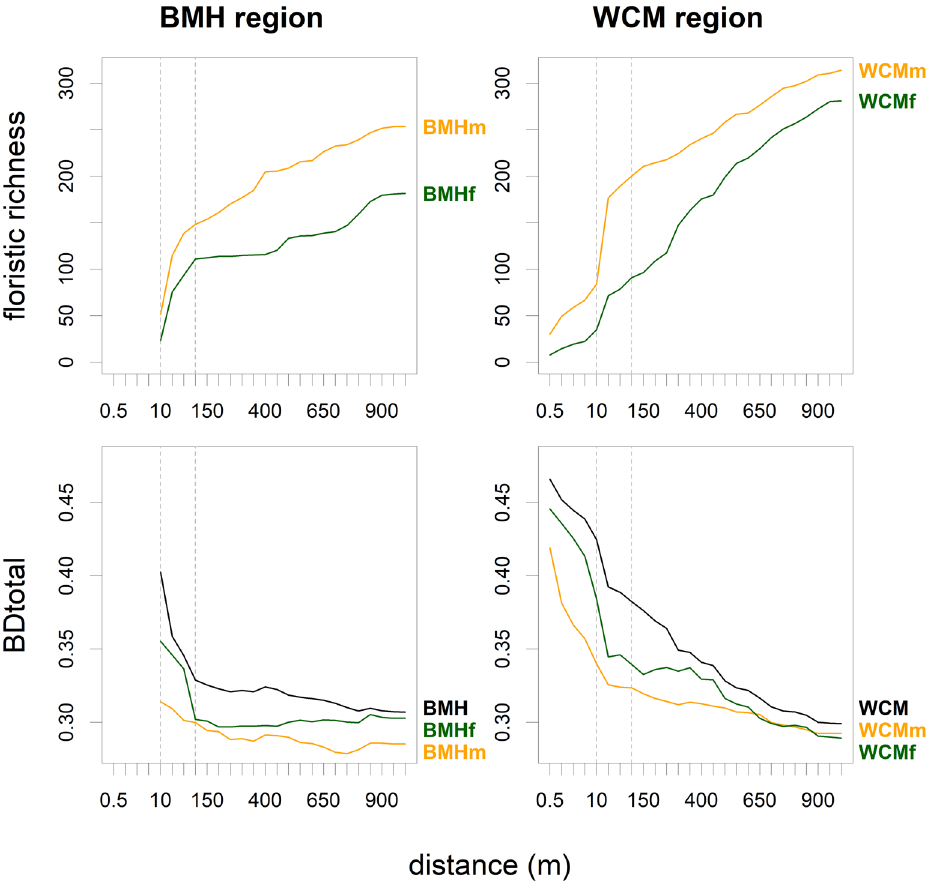
Figure 3. Spatial scaling of plant alpha diversity (species richness) and beta diversity (BD Total ) in two study regions and their different habitats. The mean number of plant species appearing in the vegetation survey (top) and their total variance (bottom). Open habitats are indicated by the yellow line, forest by the green line, and both habitats together by the black